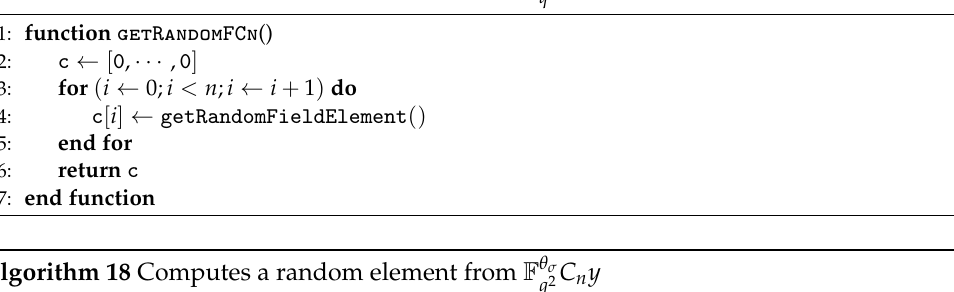
Algorithm 17 Computes a random element from F θ σ